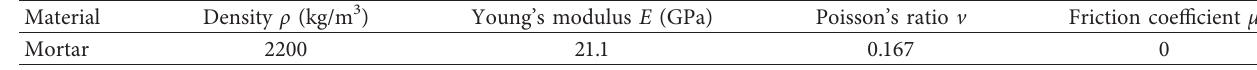
Table 1: Material properties of the FEM